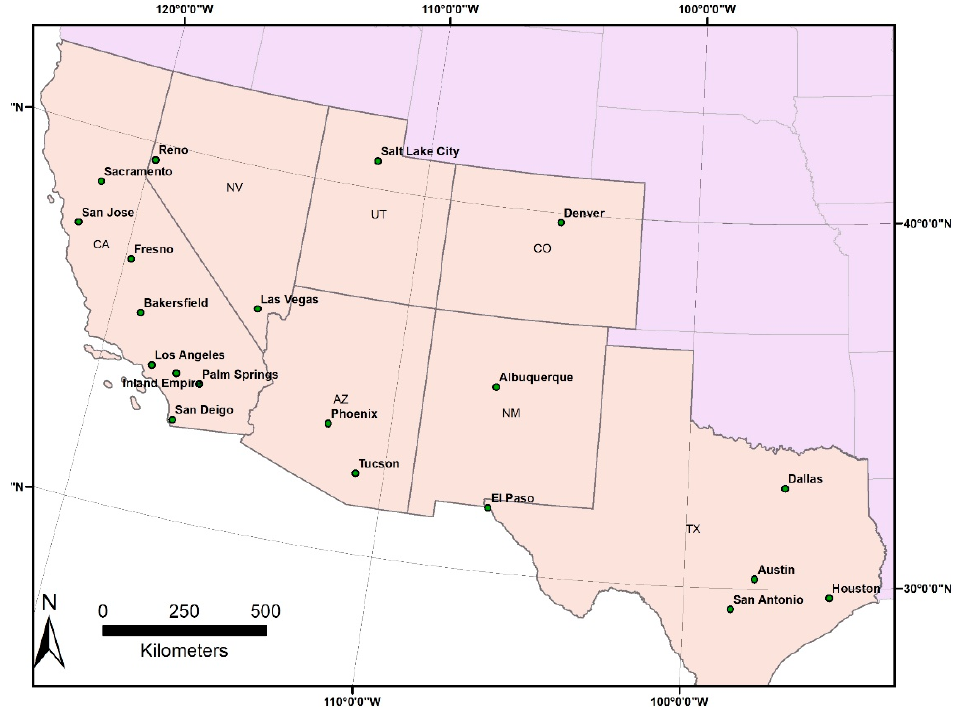
Figure 1. The 20 Southwestern cities under investigation.